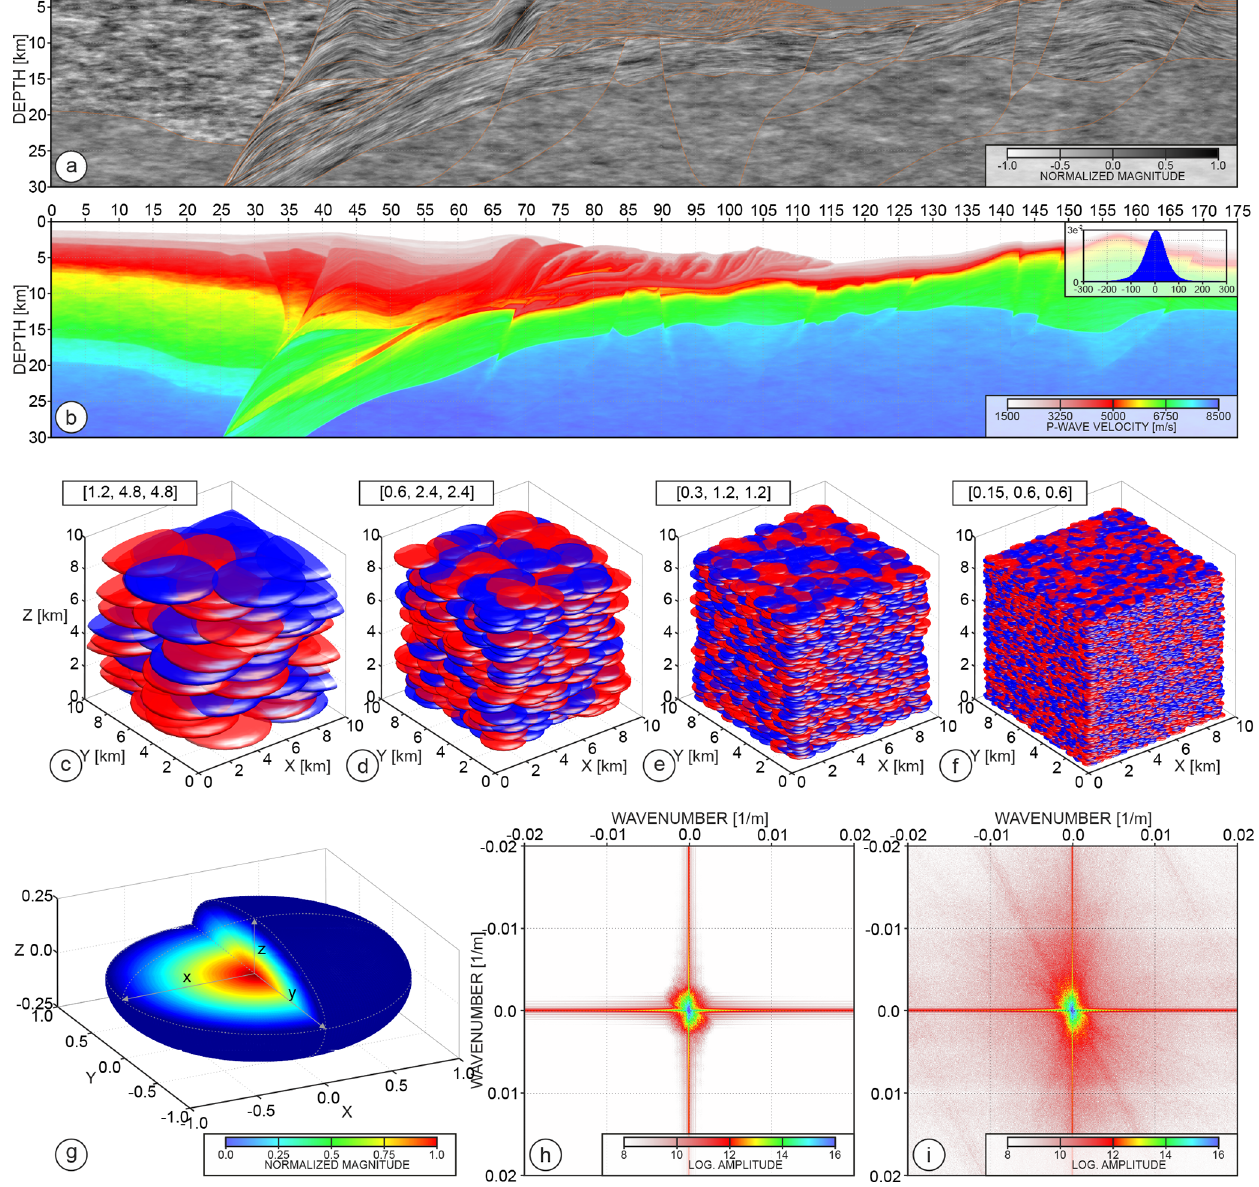
Figure 7. (a) Matrix of stochastic perturbations for a 2D inline section. (b) V p model shown in Fig. 4c after the application of the stochastic perturbations shown in (a) . (c–f) 3D stack of structural elements of different scales – see the correlation lengths in brackets. Red/blue colours indicate positive/negative magnitudes of the stacked structural elements. (g) Shape of the 3D structural element used to generate the stochastic perturbations. (h, i) Wavenumber spectrum of the 2D V p inline section with and without stochastic